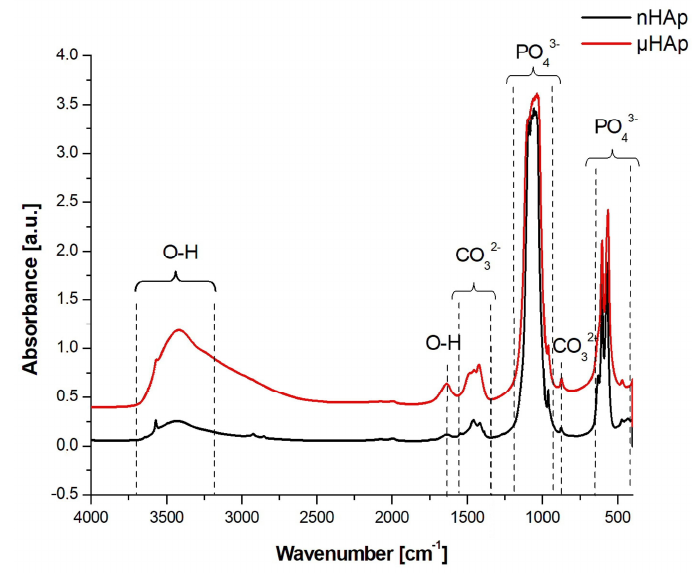
Figure 3. FTIR spectra in the range of 4000–450 cm − 1 recorded for HAp powders with nano- and microscale particles.